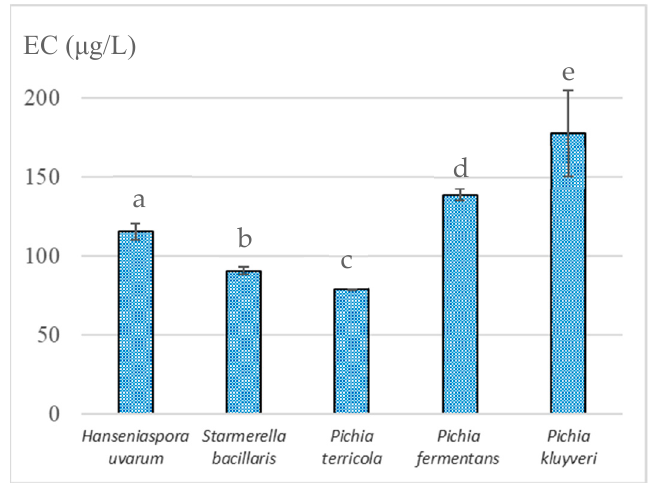
Figure 2. Ethyl carbamate concentration in fortified wines exposed to accelerated aging at 70 °C for 1 month and previously fermented with different indigenous non- Saccharomyces yeasts isolated from Madeira Island vineyards; different letters denote statistically significant differences ( p < 0.05) according to Holm–Sidak test. Data represent the average taken from duplicate experiments.